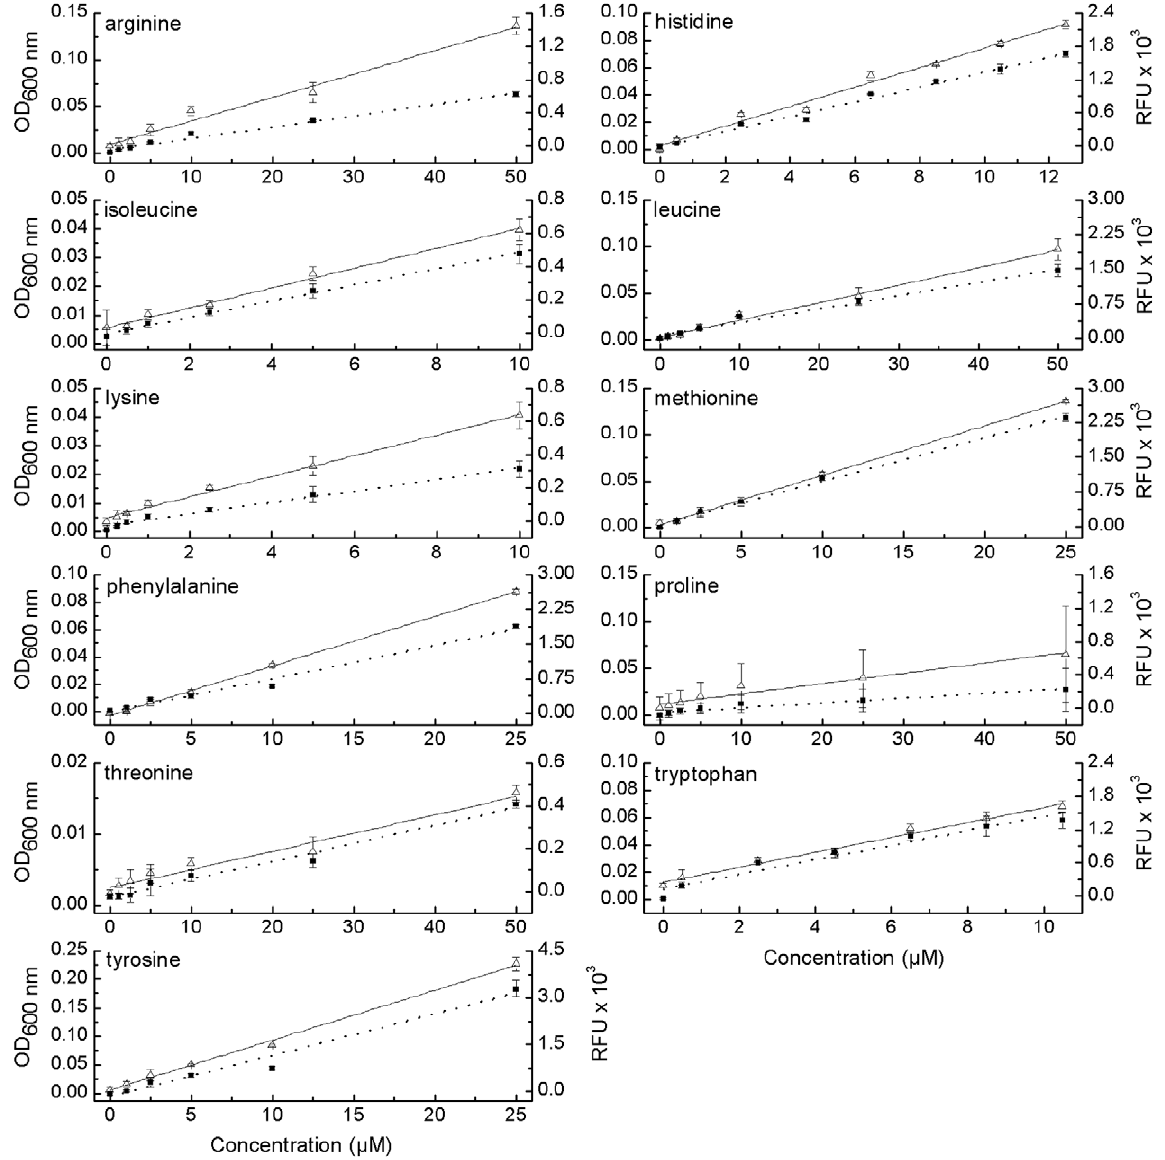
Figure 2. Amino acid-dependent growth of the eleven GFP-labeled biosensors. Each biosensor was cultivated in minimal medium, to which increasing concentrations of the required focal amino acid have been added. Cell growth was measured either turbidometrically (OD 600 nm , & ) or as relative fluorescence units (RFU, D ) after 18 h (histidine, arginine, tryptophan, isoleucine, methionine, phenylalanine, tyrosine, proline and lysine) or 24 h (leucine and threonine) of cultivation. Means ( 6 95% confidence interval) of four replicates are given.